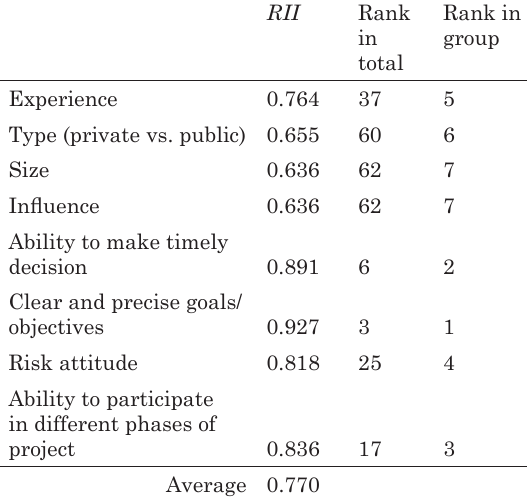
table 6. Summary of survey results on client